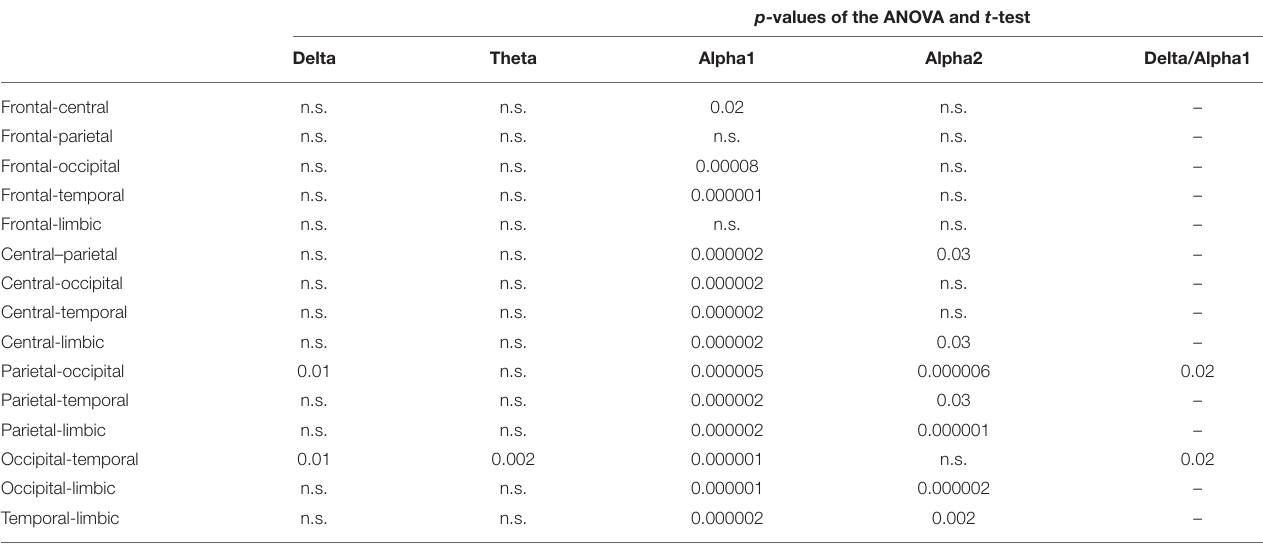
TABLE 5 | p -values (Duncan post-hoc ) of the ANOVA related to the comparisons of left intra-hemispherical lagged linear connectivity showing a statistically significant interaction [ F (84 , 18312) = 8.5942, p < 0.0001] among the factors Group (AD, Nold), ROI pairs (frontal-central, frontal-parietal, frontal-occipital, frontal-temporal, frontal-limbic, central-parietal, central-occipital, central-temporal, central-limbic, parietal-occipital, parietal-temporal, parietal-limbic, occipital-temporal, occipital-limbic, and temporal-limbic), and Band (delta, theta, alpha 1, alpha 2, beta 1, beta 2, gamma) and p -values of the t -tests for each composite EEG